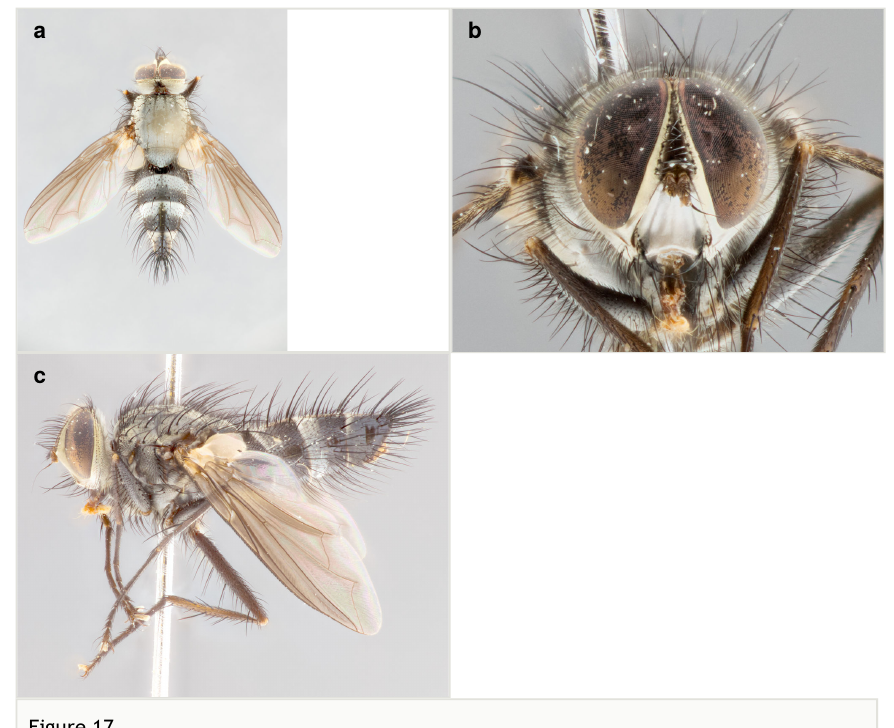
Uramya penicillata sp. nov. ; a-c : holotype male; voucher n.